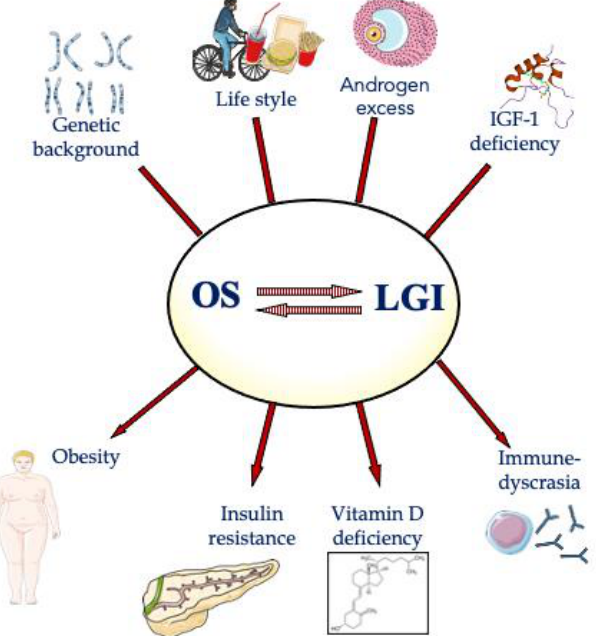
Figure 2. Figurative representation of the central role of oxidative stress (OS) and low-grade inflam- mation (LGI), with main etiological factors and consequences of their reciprocal interaction. Some illustration elements used in this figure have been kindly provided by the Servier. Servier